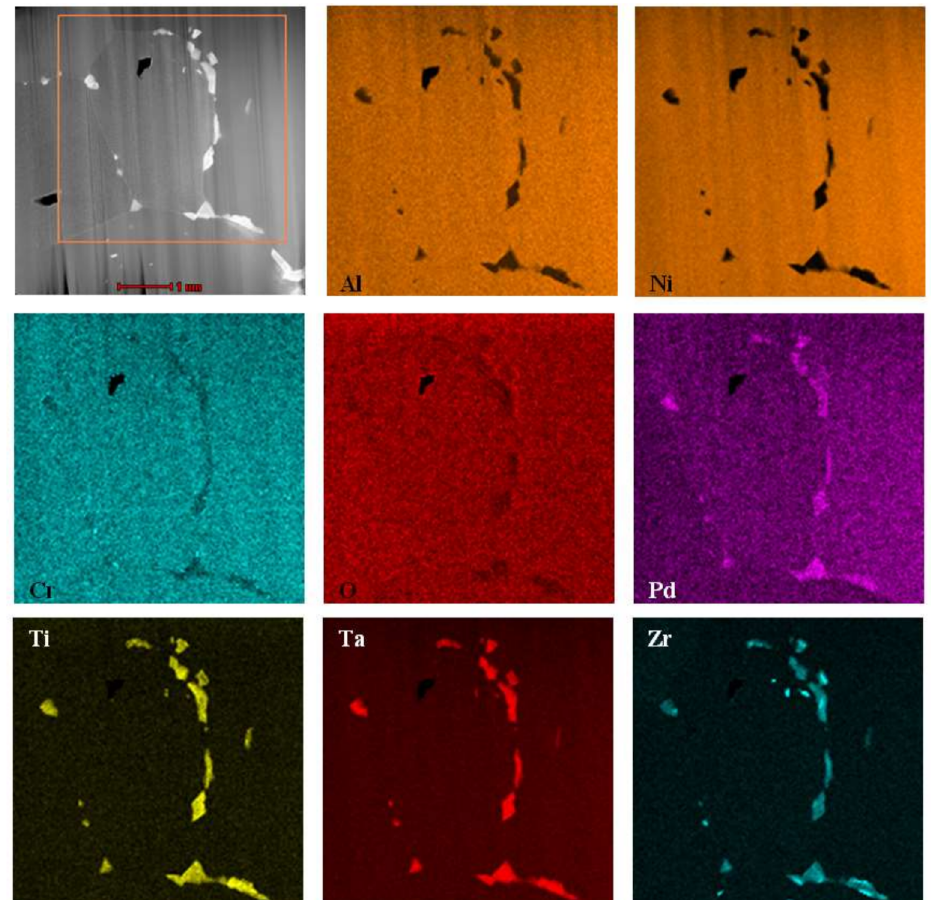
Figure 9. STEM-HAADF micrograph of Zr and Pd co-doped aluminide coating with maps presenting distribution of Al, Ni, Cr, O, Pd, Ti, Ta and